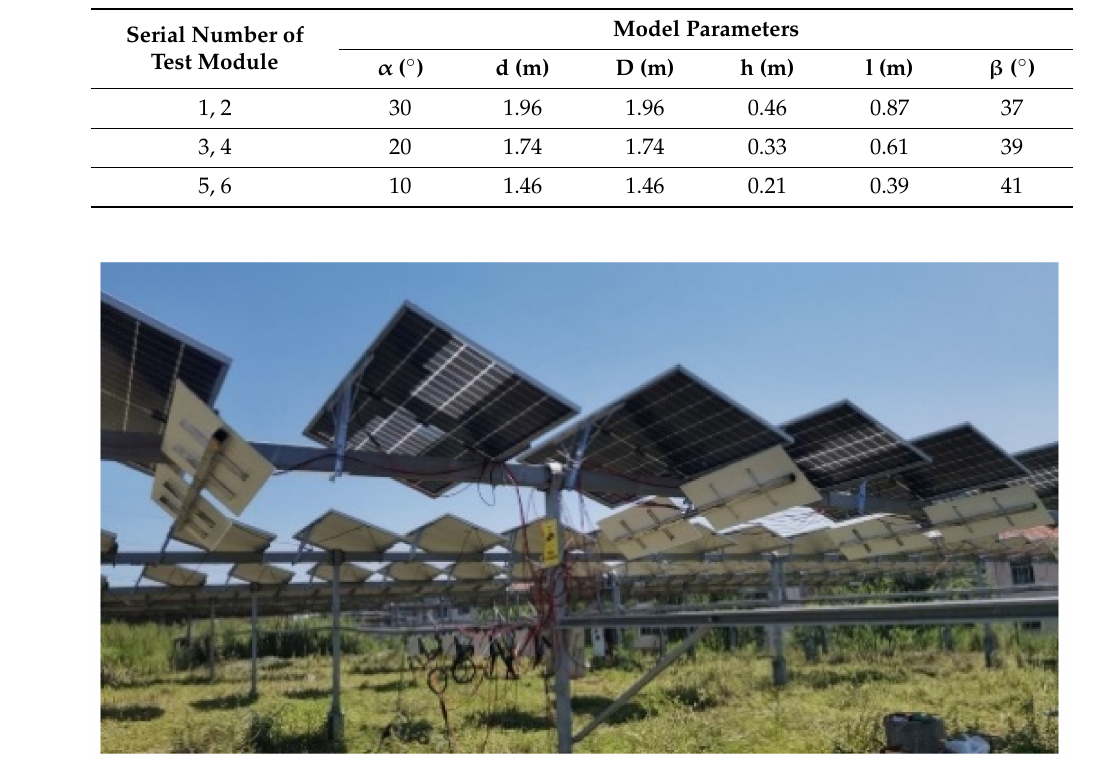
Table 4. Structural parameters and reflector arrangement for the test modules.